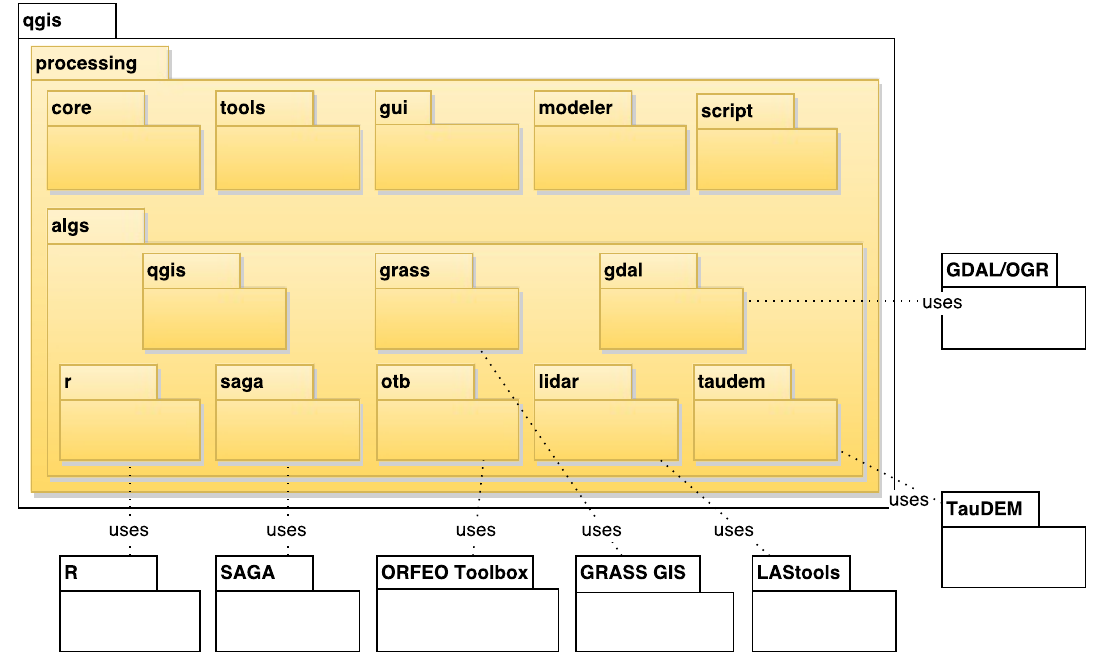
Figure 1. Package diagram with Processing packages (highlighted in yellow) and related